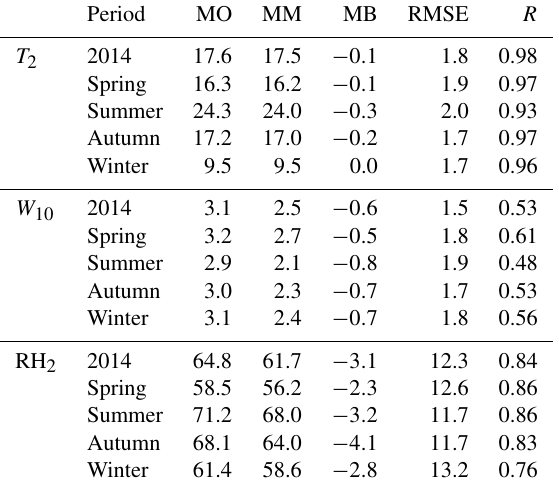
Table 2. Summary of the statistical analysis of annual and seasonal meteorology in the nested domain compared with NCDC sites. Sea- sons are defined as spring (March–May), summer (June–August), fall (September–November), and winter (December–February). MO, MM, RMSE, and R represent mean value of the observations, mean value of the model, root mean square error, and correlation coefficients respectively. T 2 , W 10 , and RH 2 represent temperature at 2m ( ◦ ), wind speed at 10m (ms − 1 ), and relative humidity at 2m (%)